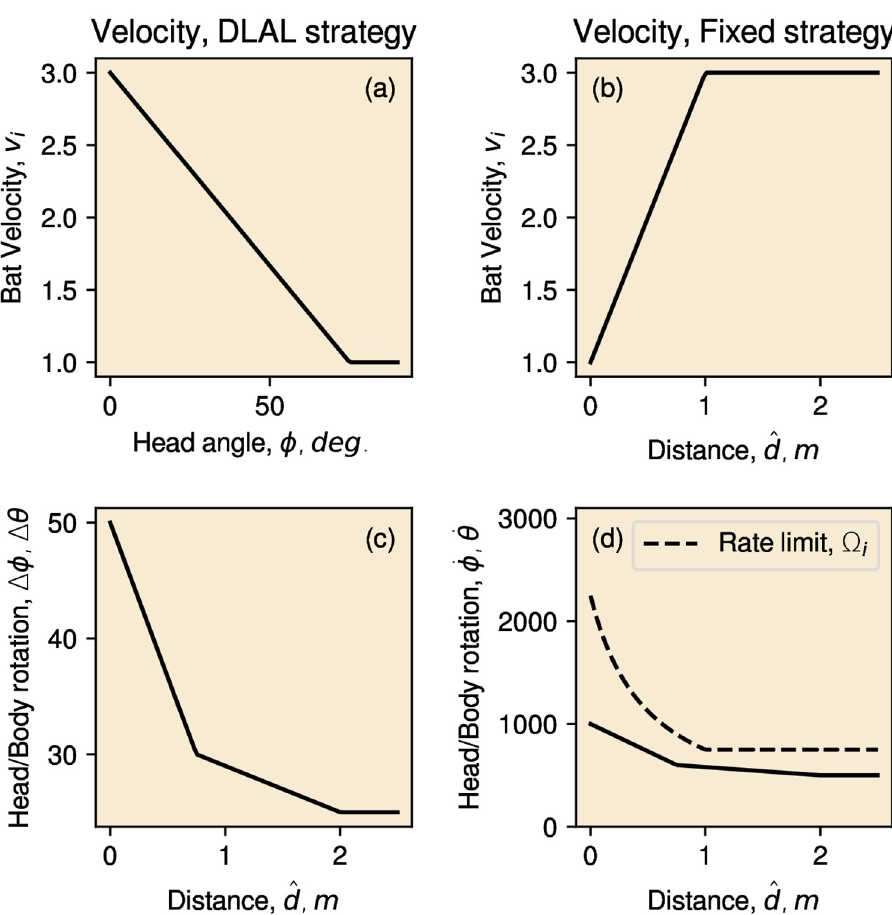
Fig 4. Curves depicting the relationship between the variables in our models. (a) The simulated velocity for the DLAL Strategy as a function of distance ^ d . (b) The simulated velocity for the Fixed Head Strategy as a function of i distance ^ d . (c) The head rotation applied between calls for the DLAL Strategy as a function of the closest echo distance i ^ d . The body rotation applied for the Fixed Head Strategy as a function of the closest echo distance ^ d i in the head (DLAL Strategy) or body (Fixed Head Strategy) orientation between calls (panel a) together with the interpulse interval modeled, implies a rotational velocity of the head (DLAL Strategy) or body (Fixed Head Strategy). This panel plots the implied velocities. This panel also shows the maximum body rotational velocity as observed across bat species flying at different speeds by Holderied et al. [42]. In generating this curve, the velocity as a function of distance ^ d for the Fixed Head Strategy is used (panel i